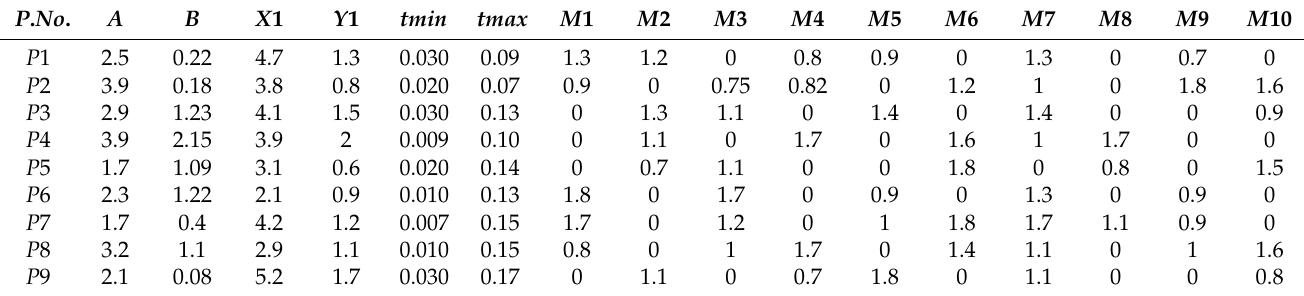
Table 6. Cost and time function constants of each process of knuckle joint